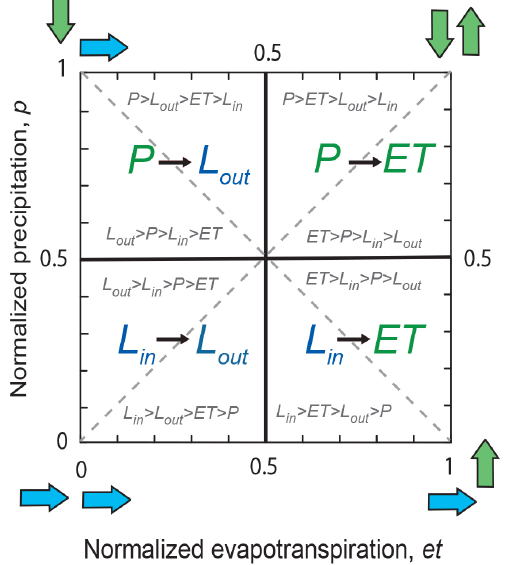
Figure 5. Dominant flow-path-regime classification, for use in wa- ter management applications. Blue-and-green arrow combinations at corners of plot depict the four end-member hydroclimatic regimes of Fig. 1c. Dominant flow paths are defined as the largest inflow– outflow combinations characterizing each of the four quadrants of the plot (i.e., P → E T , L in → L out , P → L out , or L in → E T ). Rela- tive magnitudes of all individual flows are shown in the background of each quadrant. For definitions of all terms, see Table